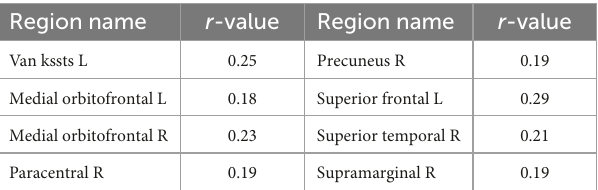
TABLE 3 Significant correlation r -values between alpha peak frequency and depressive score.